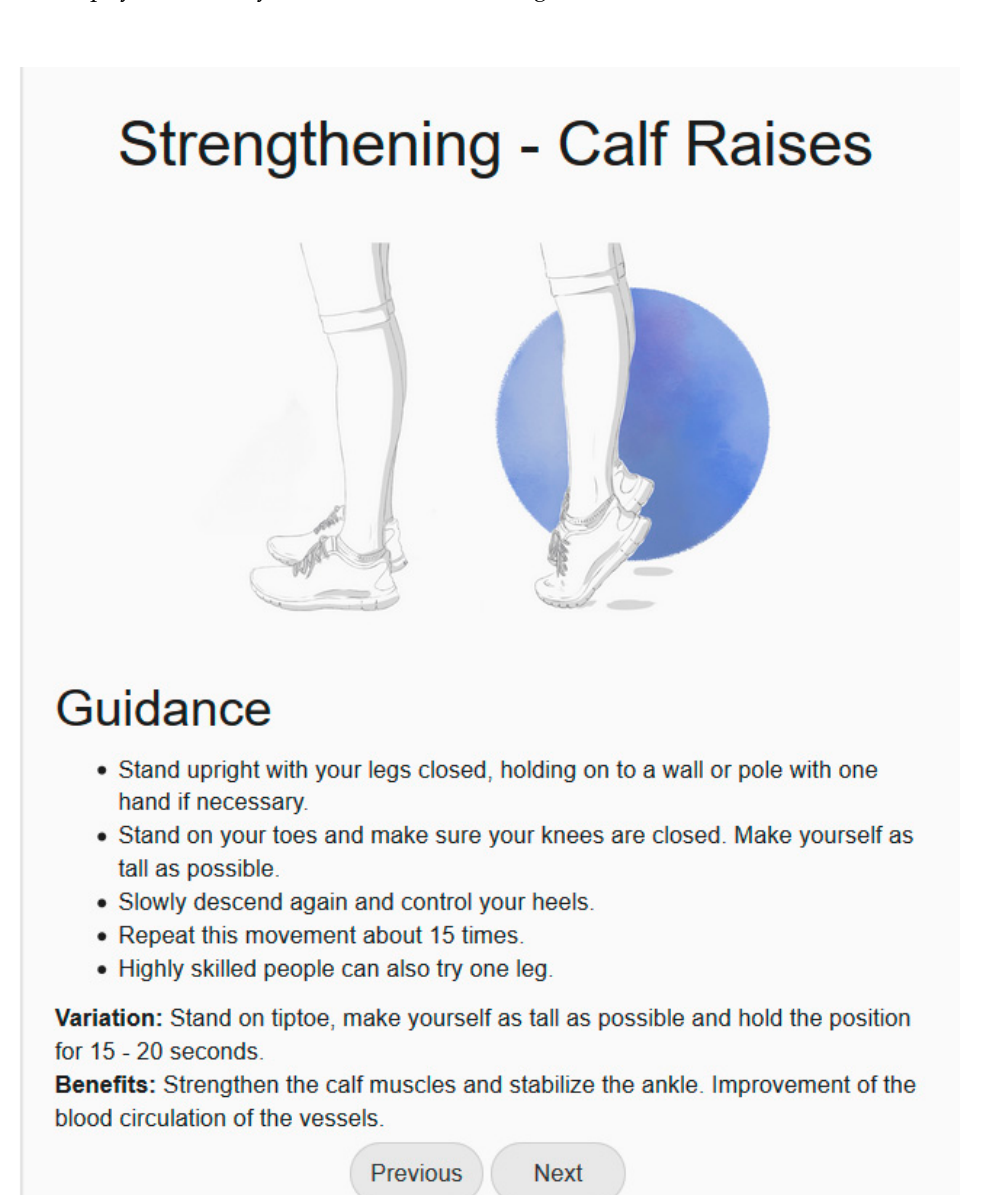
Figure 4. Exercise for strengthening. Visualization by TraffiCon GmbH, Salzburg.